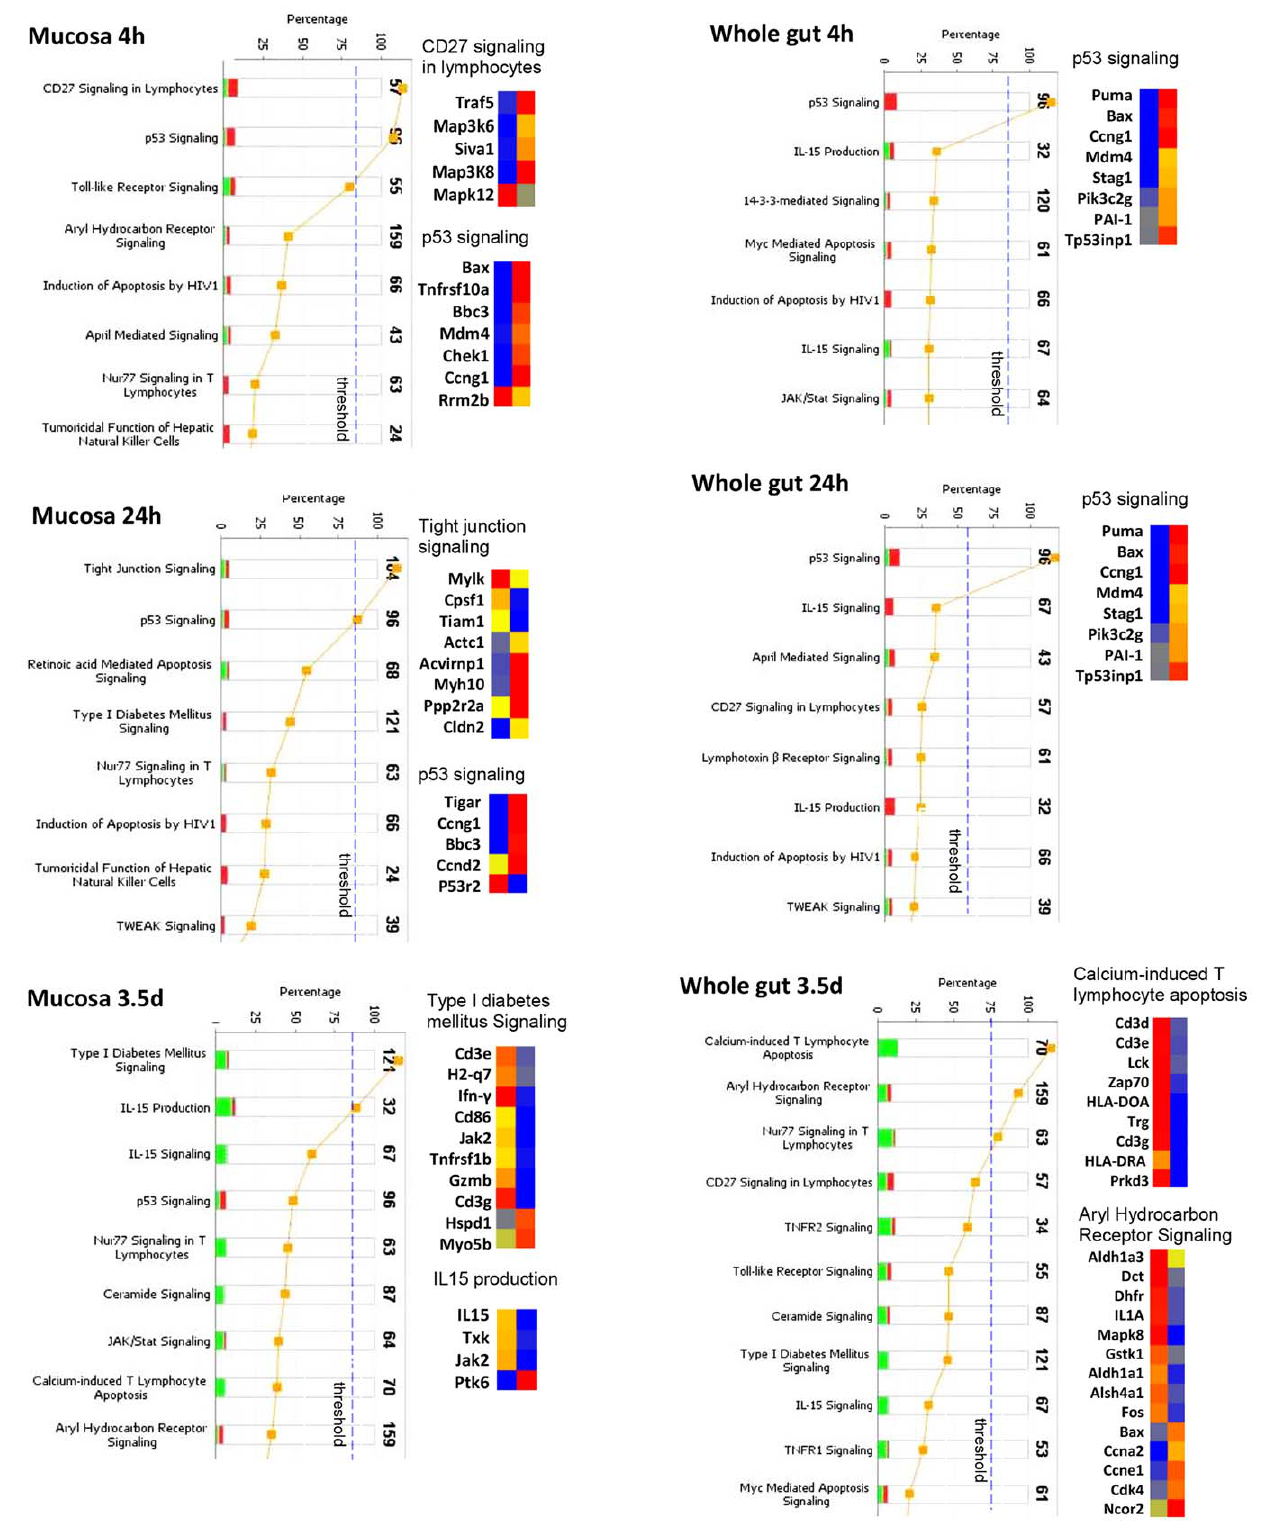
Figure 7. Activation of apoptosis pathways in mucosa and whole gut. Stacked bar charts demonstrate IPA-generated activated apoptosis pathways in mucosa and whole gut at 4 h, 24 h, and 3.5 d after irradiation. The height of the bars indicates the percentage of genes that changed in the particular pathway. Red bar: up-regulated. Green bar: down-regulated. Pathways with p-value (yellow dot) above the threshold (dashed line) are significantly activated. Heatmaps demonstrate the change of the genes in the selected signaling pathway before (left column) and after radiation (right column). Blue: decreased, red: increased.